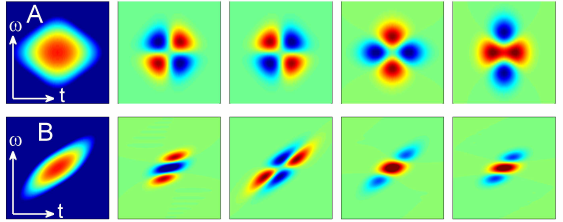
Figure 3: The time frequency map evolutions of the pulses in fiber laser cavities with (A) anomalous dispersion and (B) normal dis- persion. In each row, the first figure is the time frequency map of the initial pulse and other four figures are the variations induced by SPM, GVD, saturable absorption, and spectral filtering, respec- tively. The warm colors (red side) indicate high intensity or intensity increasing and the cool colors (blue side) indicate low intensity or intensity